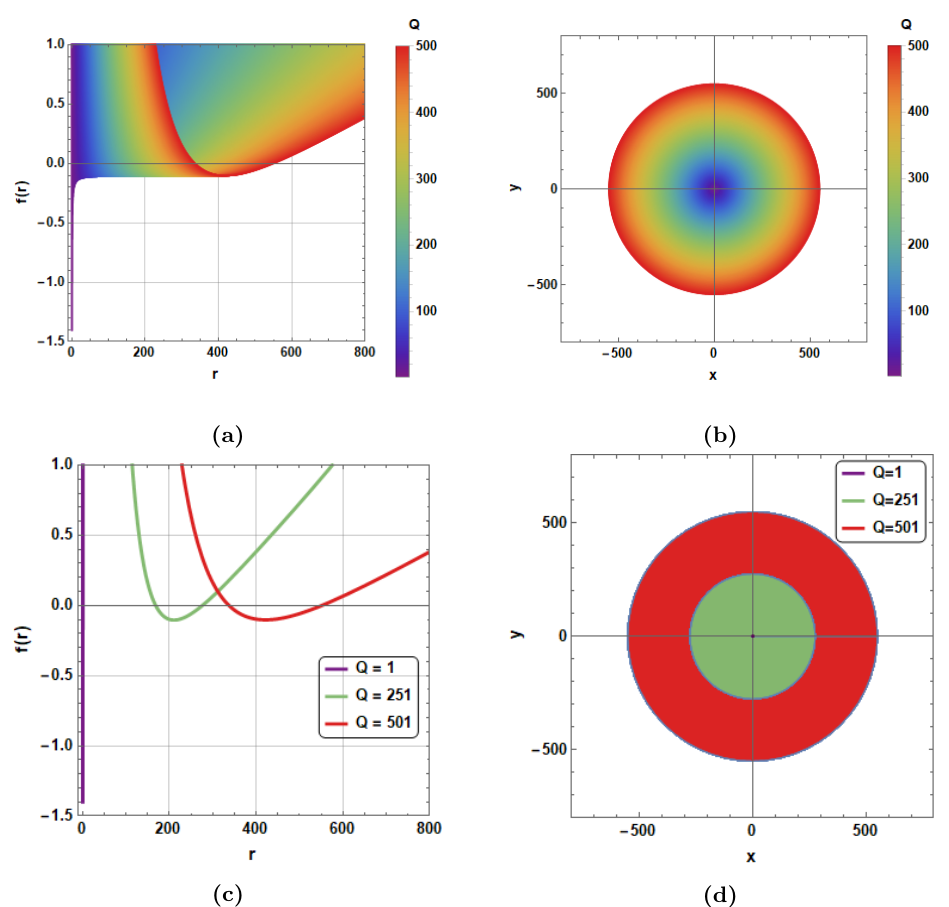
Figure 29. (a) and (c): evolution of f ( r ) function during absorption of 10 5 particles with a fixed electric charge dQ = 0 . 005 . (b) and (d): evolution of black hole projection on xy plan during absorption of 10 5 particles with a fixed electric charge dQ = 0 . 005 . The initial conditions are Q 0 = 1 , l = 1 , M 0 = 1 . 67 , r h = 1 . 1 and D = 4